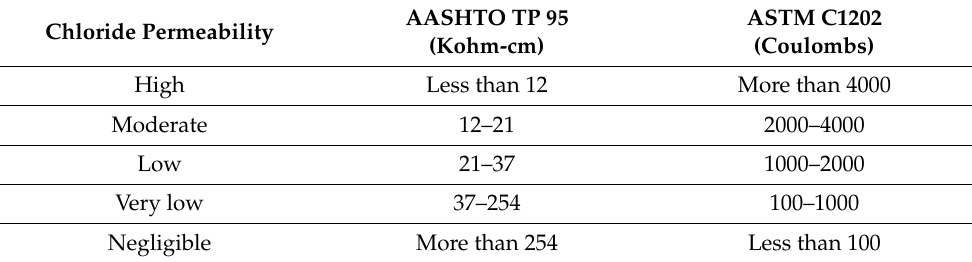
Table 6. Chloride penetrability classification.